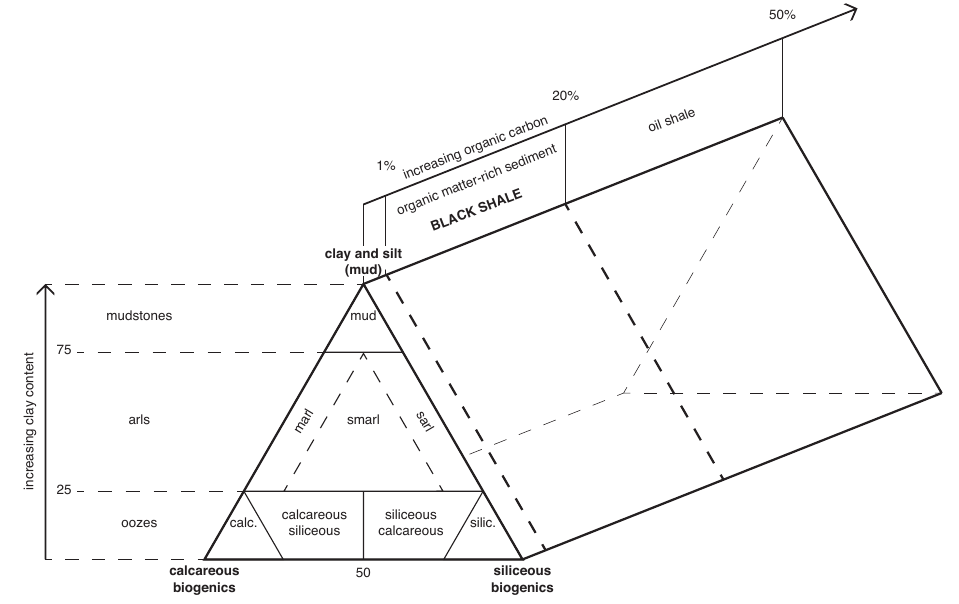
Fig. 2. Classification of fine-grained marine rocks based on composition. Black shales are organic matter-rich sedimentary rocks with varying relative proportions of mud and biogenic components. Table 1. Summary of black shale occurrence with respect to Wilson Cycle stages and their respective depositional environments.